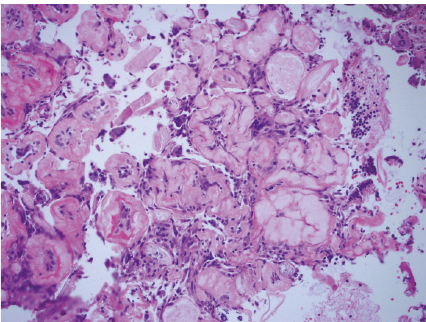
Figure 3: Pulse granuloma with the characteristic eosinophilic hyaline rings and spiral body (bottom left corner) which is a plant vascular structure (H&E, original magnification ×